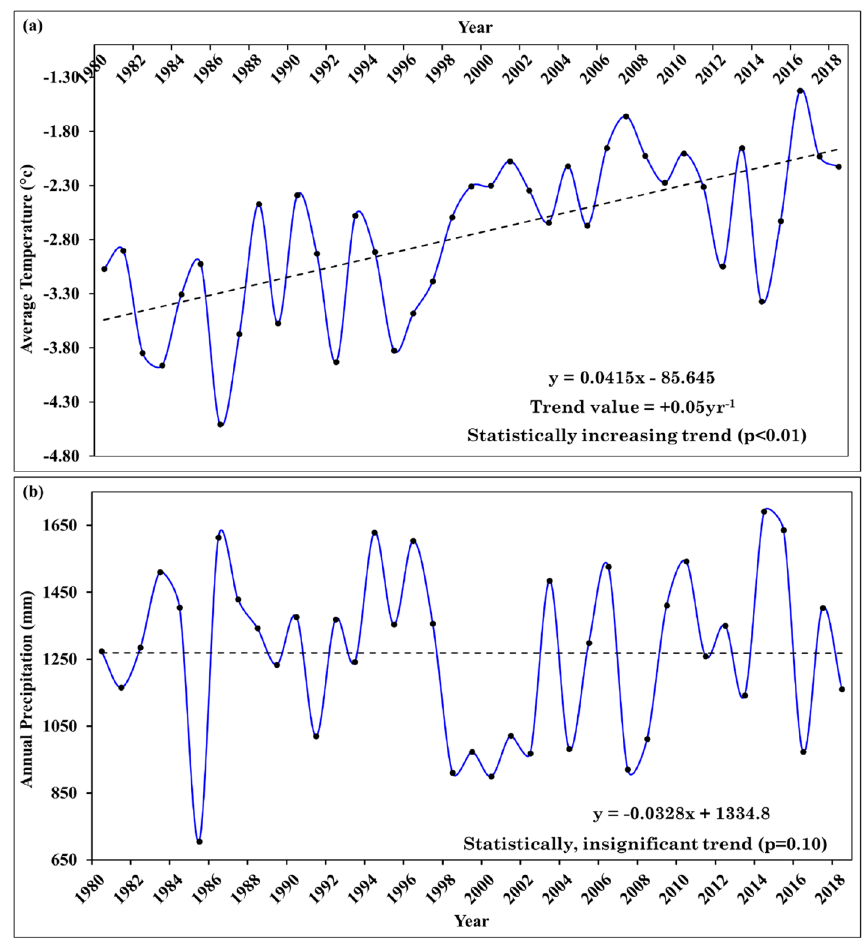
Figure 5. Temporal variations of ( a ) average annual temperature on the Hoksar Glacier from 1980 to 2018 calculated by using the temperature lapse-rate from the nearest observatory at Pahalgam (19 km away), and ( b ) total annual precipitation observed from 1980 to 2018 at